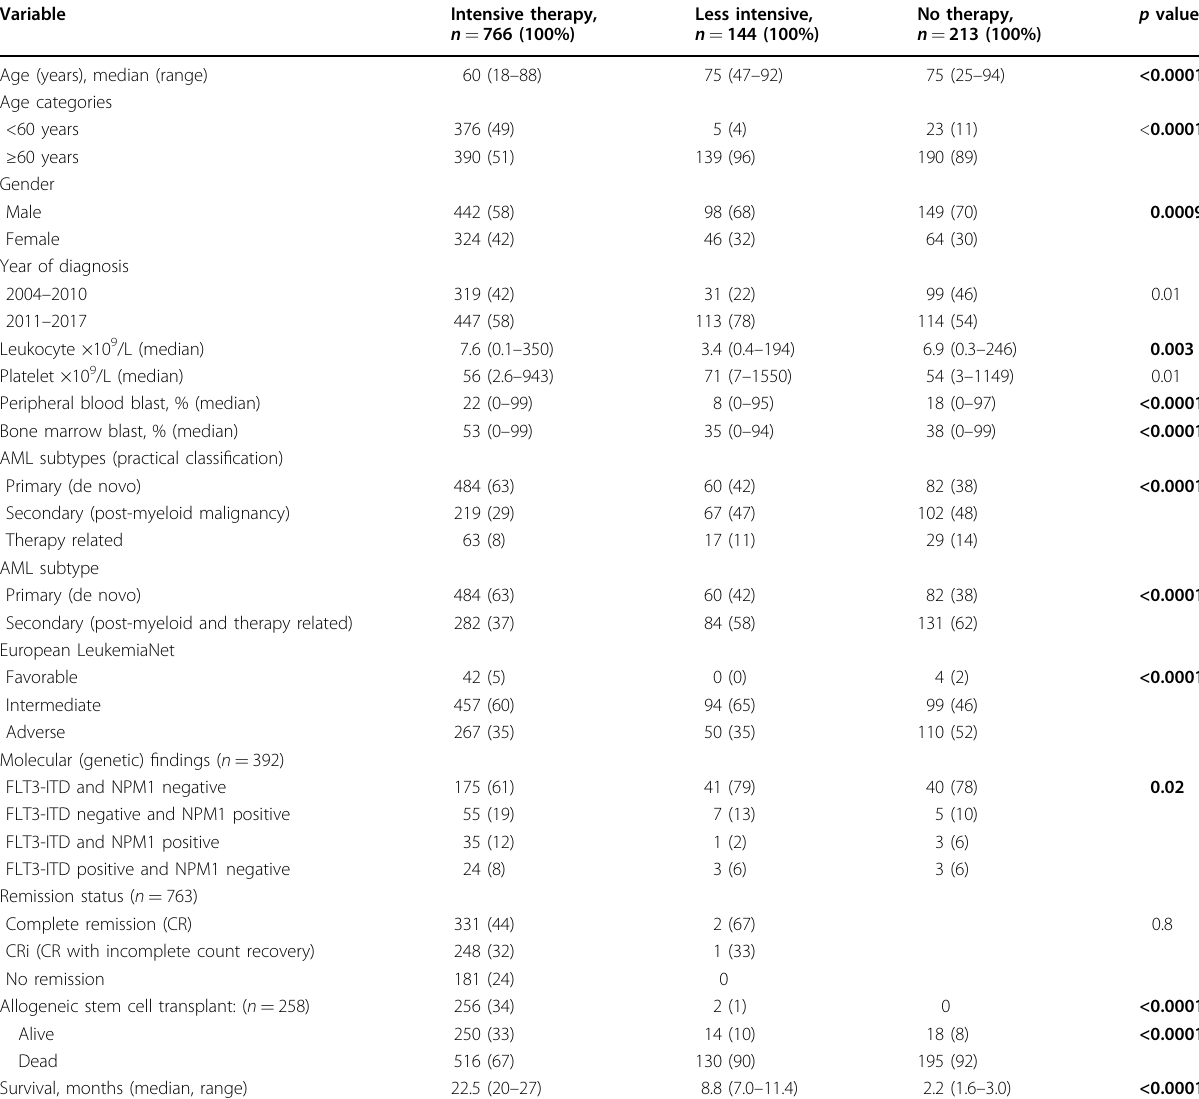
Table 3 Clinical and laboratory characteristics of acute myeloid leukemia (Non-APL) patients with complete cytogenetic